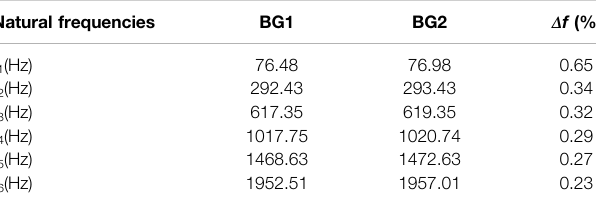
TABLE 2 | Comparison of the natural frequencies of BG1 and BG2. Natural frequencies